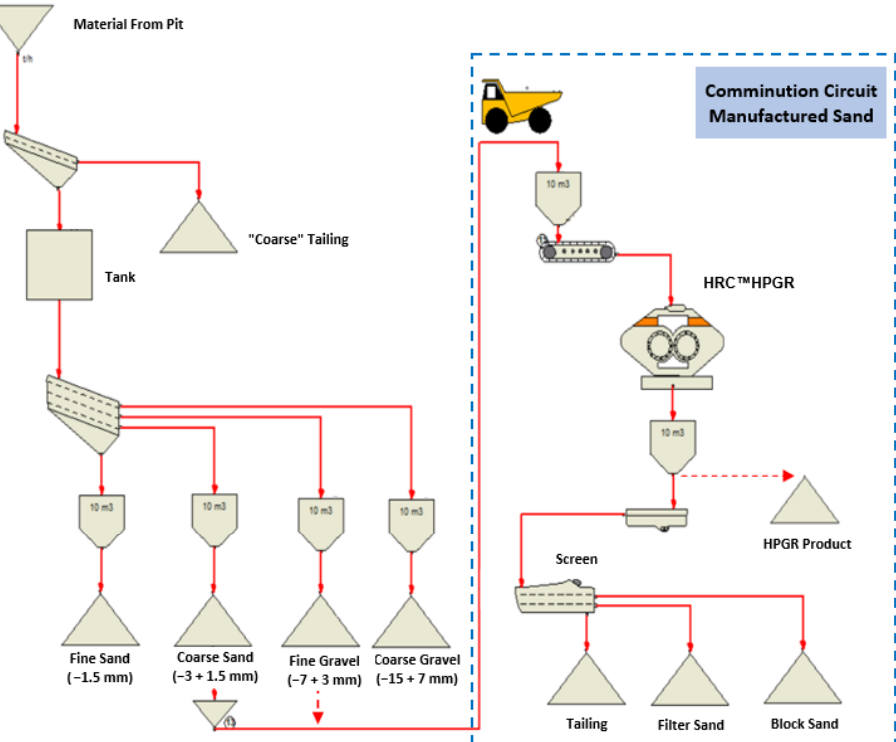
Figure 2. Itaquareia processing plant flow sheet.